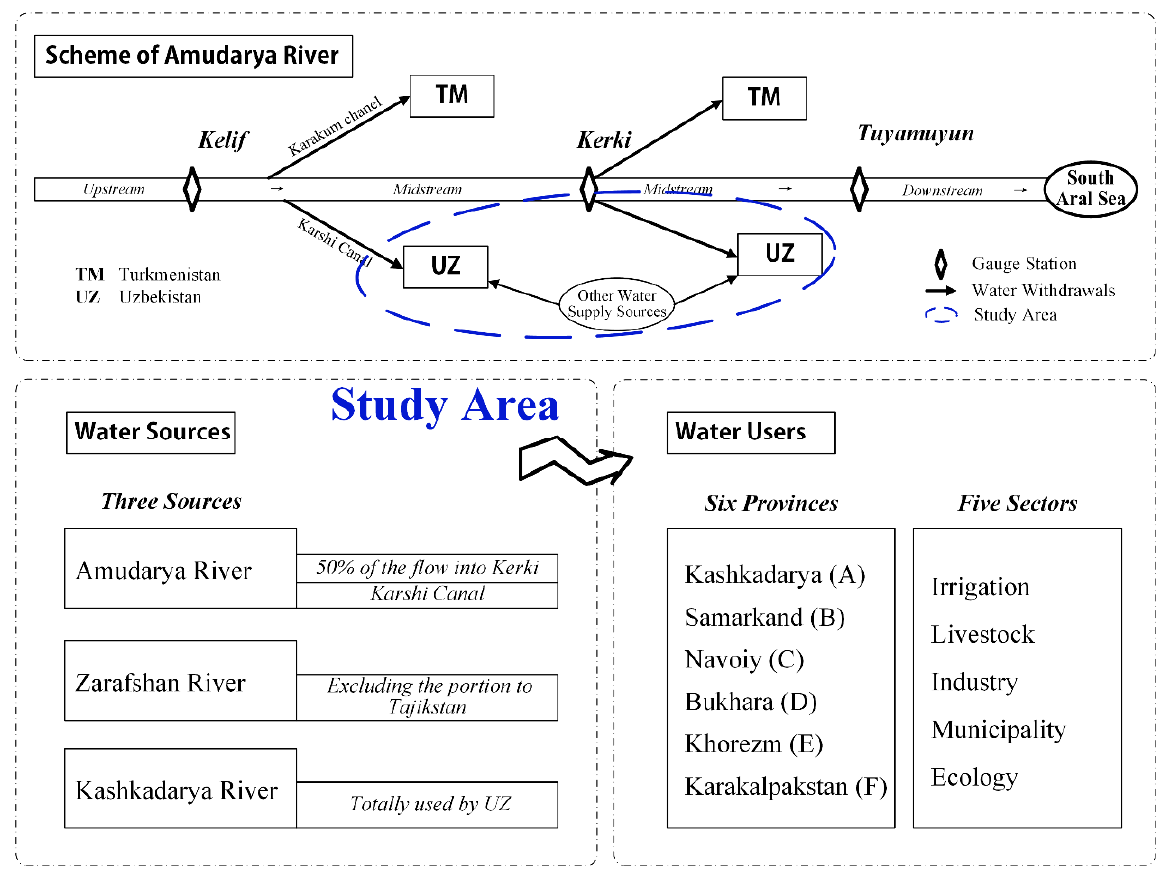
Figure 2. Scheme of the water system in the study area.